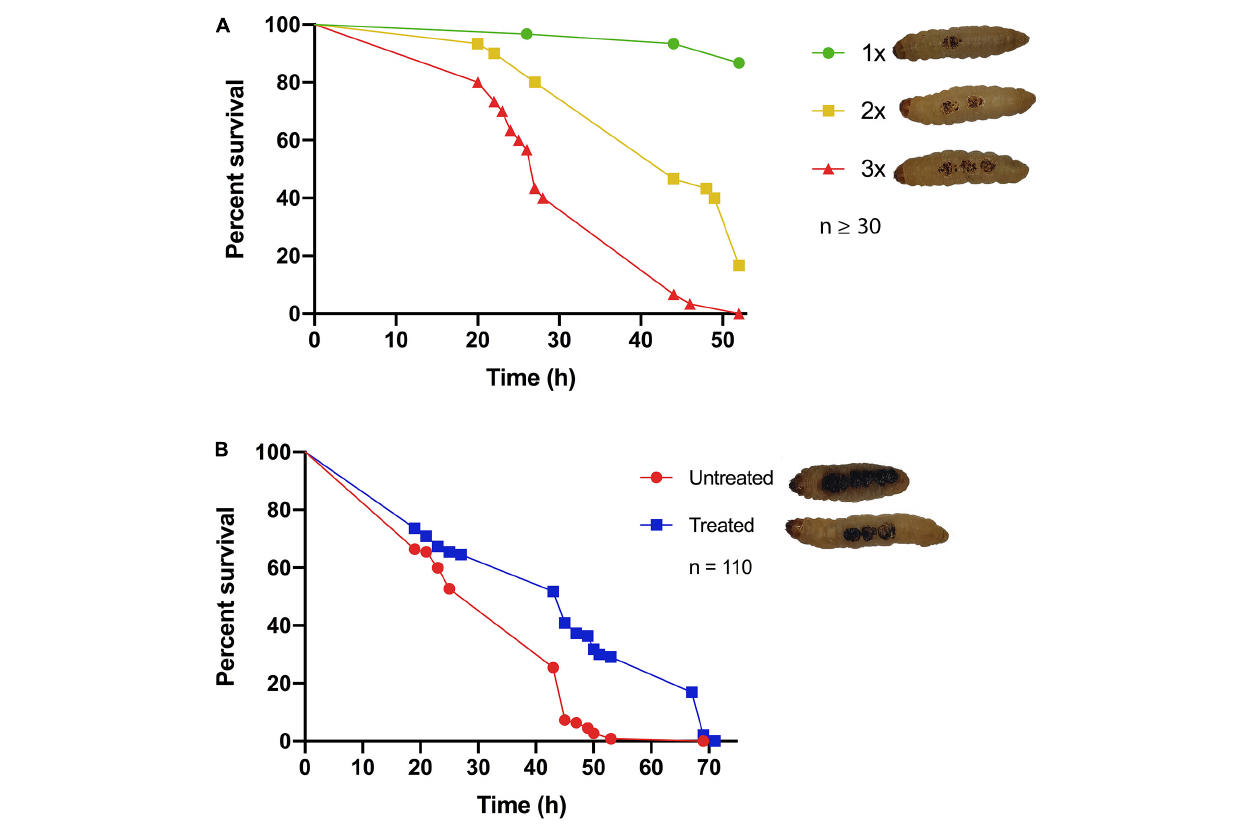
FIGURE 2 | Hallmarks of burn trauma: (A) Total burn surface area (TBSA) correlates with survival: it is well established in burn patients that the larger the TBSA, the greater the risk of mortality. We demonstrate that this central dogma can be recapitulated in the G. mellonella burn wound model. 1x = 2 mm 2